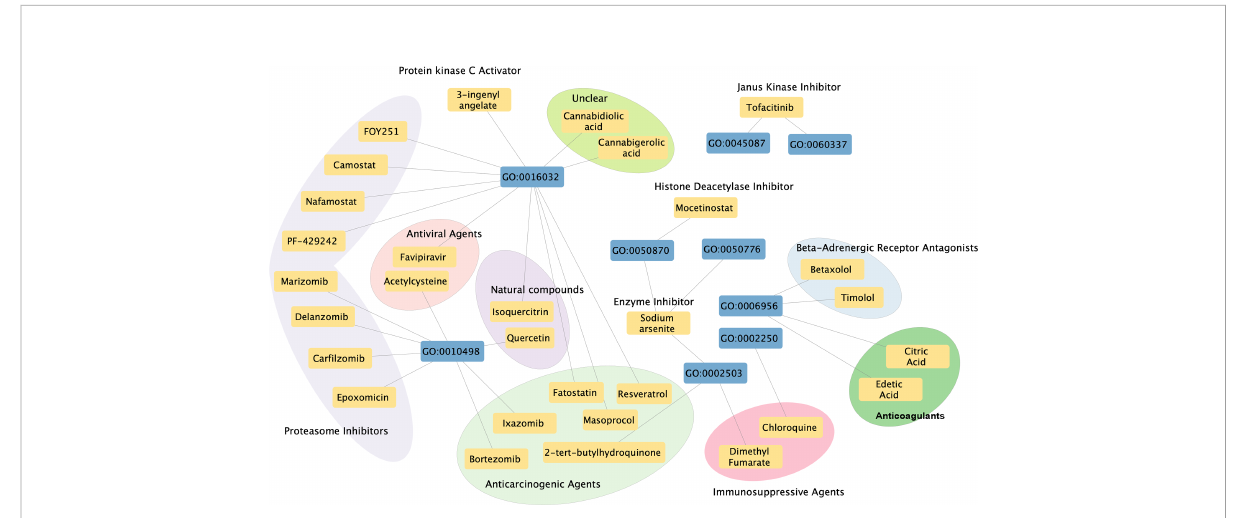
FIGURE 5 Chemical – biological process interaction network. Blue boxes indicate signi fi cant enriched GO pathways, and yellow boxes indicate potential therapeutic chemicals. Each line indicates an interaction between the GO pathway and chemical. Circles indicate chemicals that serve the similar